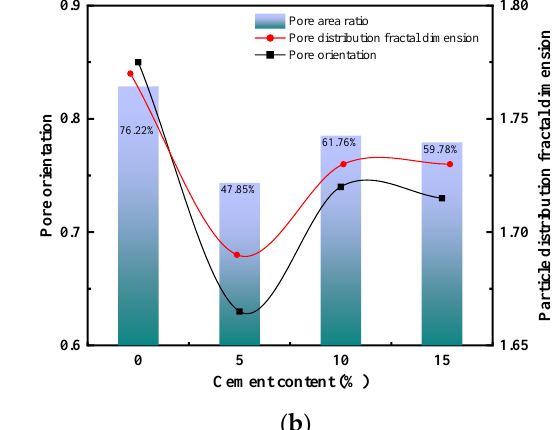
Figure 10. Binarized image of microstructure of permeation grouting muddy clay. ( a ) Cement con- tent of 0%. ( b ) Cement content of 5%. ( c ) Cement content of 10%. ( d ) Cement content of 15%.